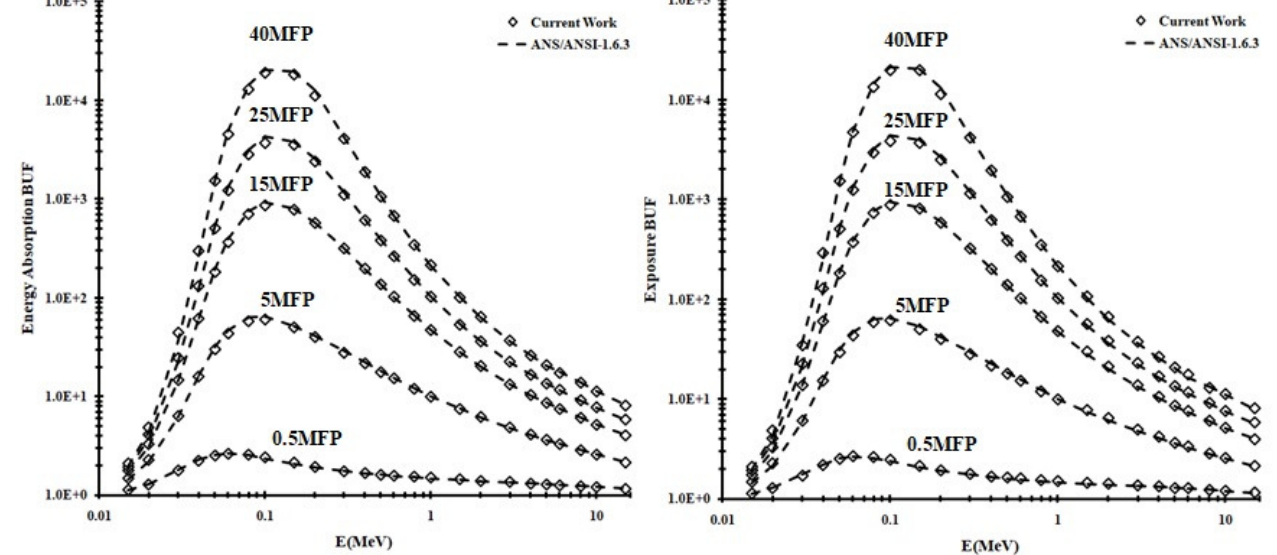
Figure 1. Comparison of calculated and standard buildup factors (( left ) EABF and ( right ) EBF) of water medium as a function of photon energy at different depths of: 0.5, 5, 15, 25, and 40